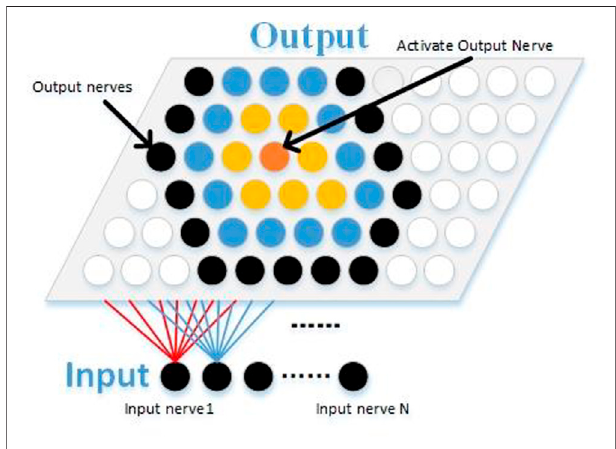
FIGURE 3 | Structure of SOM neural network.